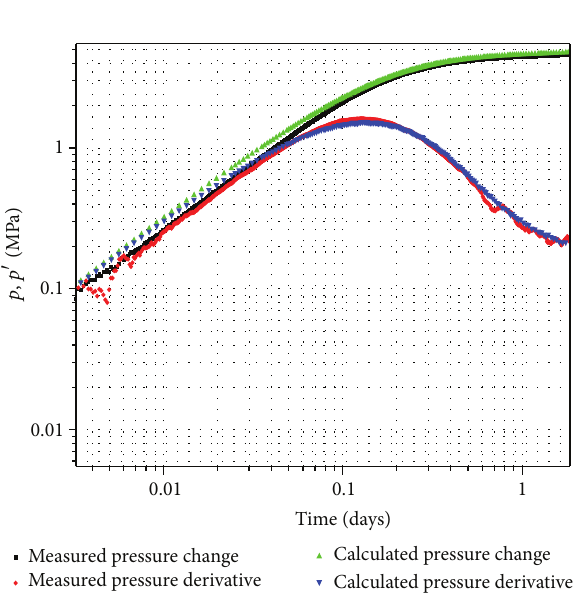
Figure 12: Gridding for the real example.